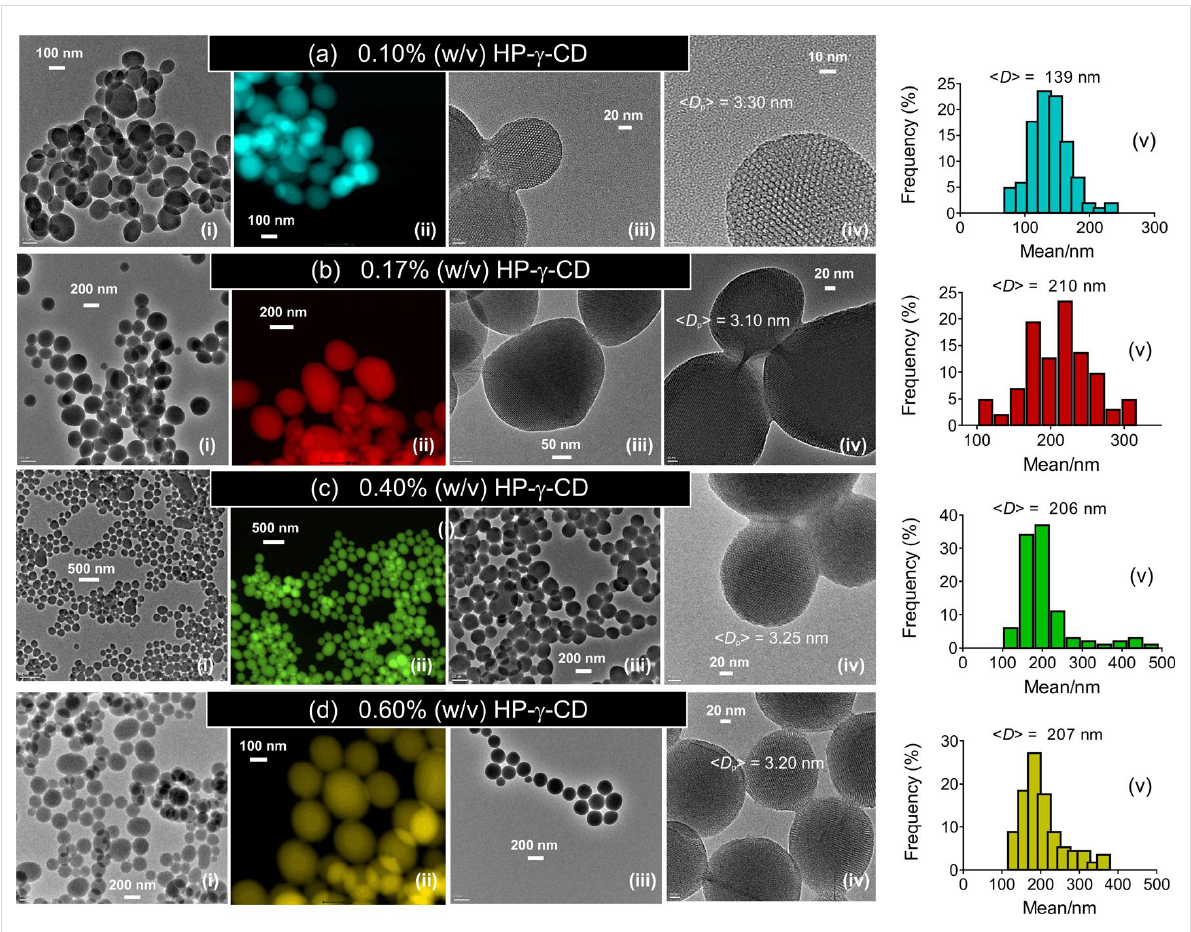
Figure 5: TEM (i, iii, iv) and colored STEM (ii) images, and as well as the particle size-distribution plots (v) of MSN particles (MSN-6-9) produced at various concentrations of HP- γ -CD (a–d). c CD = 0.10–0.60% (w/v), c CTAC = 0.20% (w/v) and r (CD/CTAC) = 0.50 (a), 0.85 (b), 2 (c) and 3 (d). < D p > denotes the mean pore size calculated from the TEM